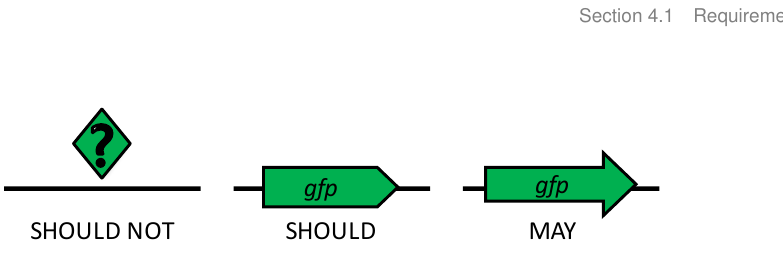
Figure 1: A biological design element such as a protein coding sequence (CDS) is best represented by the most specific RECOMMENDED glyph (middle), but can be represented by a less specific glyph such as Unspecified (left) or an approved alternative glyph